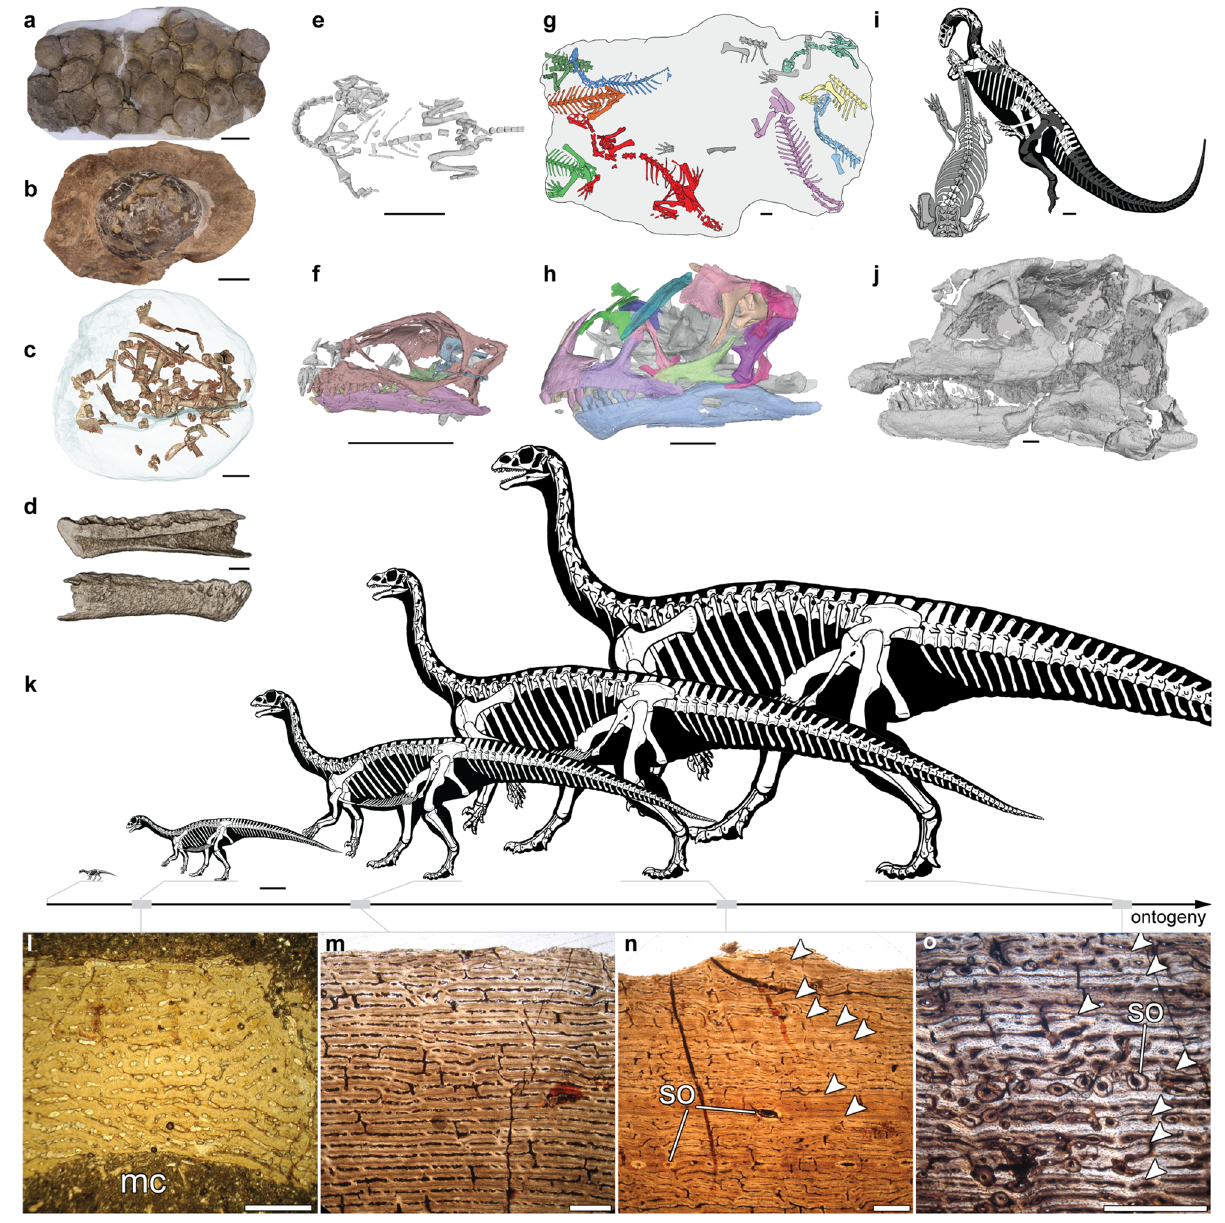
Figure 2. Specimens of Mussaurus patagonicus collected from the Laguna Colorada Formation. ( a ) nest with eggs MPM-PV 1887; ( b ), isolated egg MPM-PV 1875; ( c ) 3D reconstruction of embryo within egg MPM-PV 1879; ( d ), right dentary of embryonic remains MPM-PV 1879 showing autapomorphic traits of M. patagonicus (anterodorsal process of dentary); ( e ), 3D reconstruction of neonate 21 MACN-PV 4111; ( f ) 3D reconstruction of skull anatomy of neonate MACN-PV 4111; ( g ), associated skeletons of one-year old juveniles MPM-PV 1813; ( h ), 3D reconstruction of juvenile MPM-PV 1813/4; ( i ), associated skeletons of two adult individuals MPM-PV 1868 and MPM-PV 1869; ( j ), skull of adult individual MPM-PV 1868; ( k ), Skeletal reconstruction of the different growth stages of M. patagonicus ; ( l–o ), cortical bone histology of four different sized specimens of M. patagonicus . ( l ), MPM-PV 1813/10. ( m ) MPM-PV 1836. ( n ) MPM-PV 1838. o , MLP 60-III-20–22. Arrowheads indicate the position of lines of arrested growth. Scale bars equal 20 cm ( i , k ), 5 cm ( a , e , g ) , 2 cm ( b , f , h , j) , 5 mm ( c ) , 1 mm ( d ) , 0.5 mm ( l – o ). Drawings of silhouettes (by J. Gonzalez) represent the size of the different specimens representing the various ontogenetic stages of M. patagonicus . Abbreviations: mc: medullary cavity; so: secondary